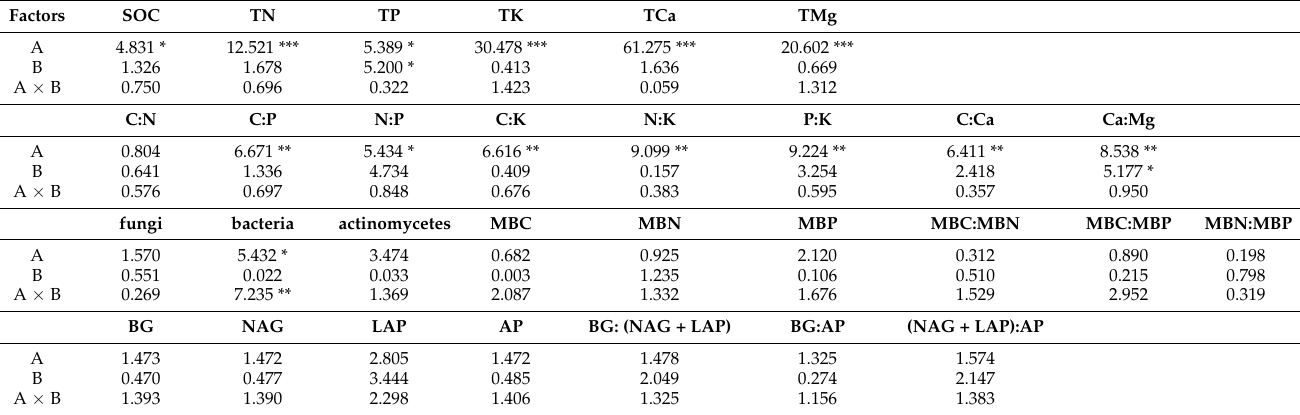
Table 2. Two-way ANOVA for the effects of plantation type and soil depth on soil, microorganisms, and extracellular enzymes and stoichiometry (value in the table are F